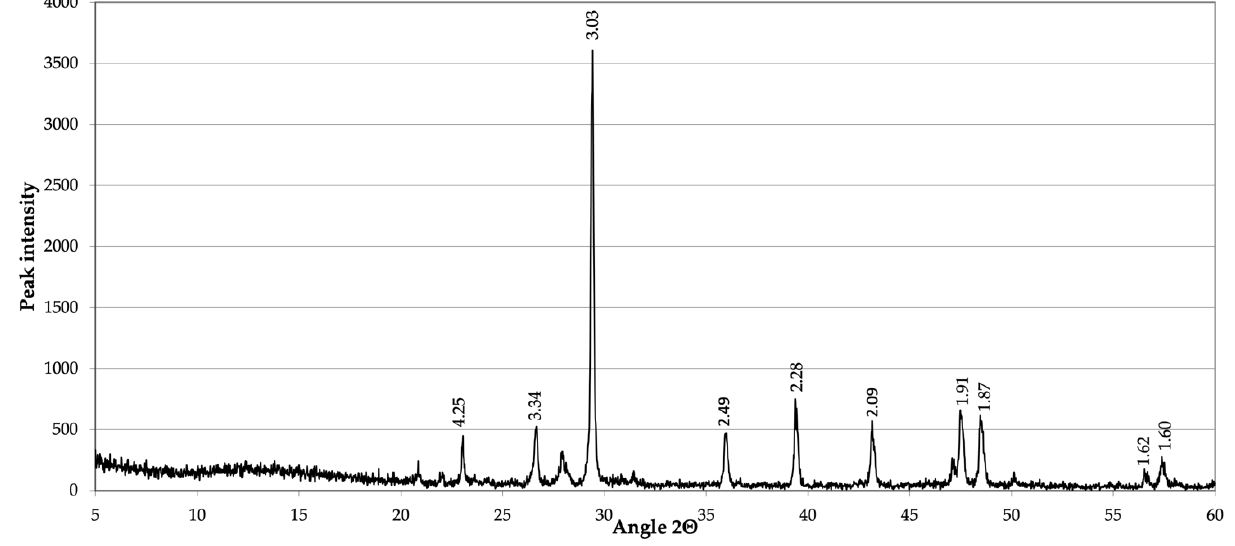
Figure 13. X-ray of a sample from the masonry of the gate tower of the Anakopia fortress (10th century AD).